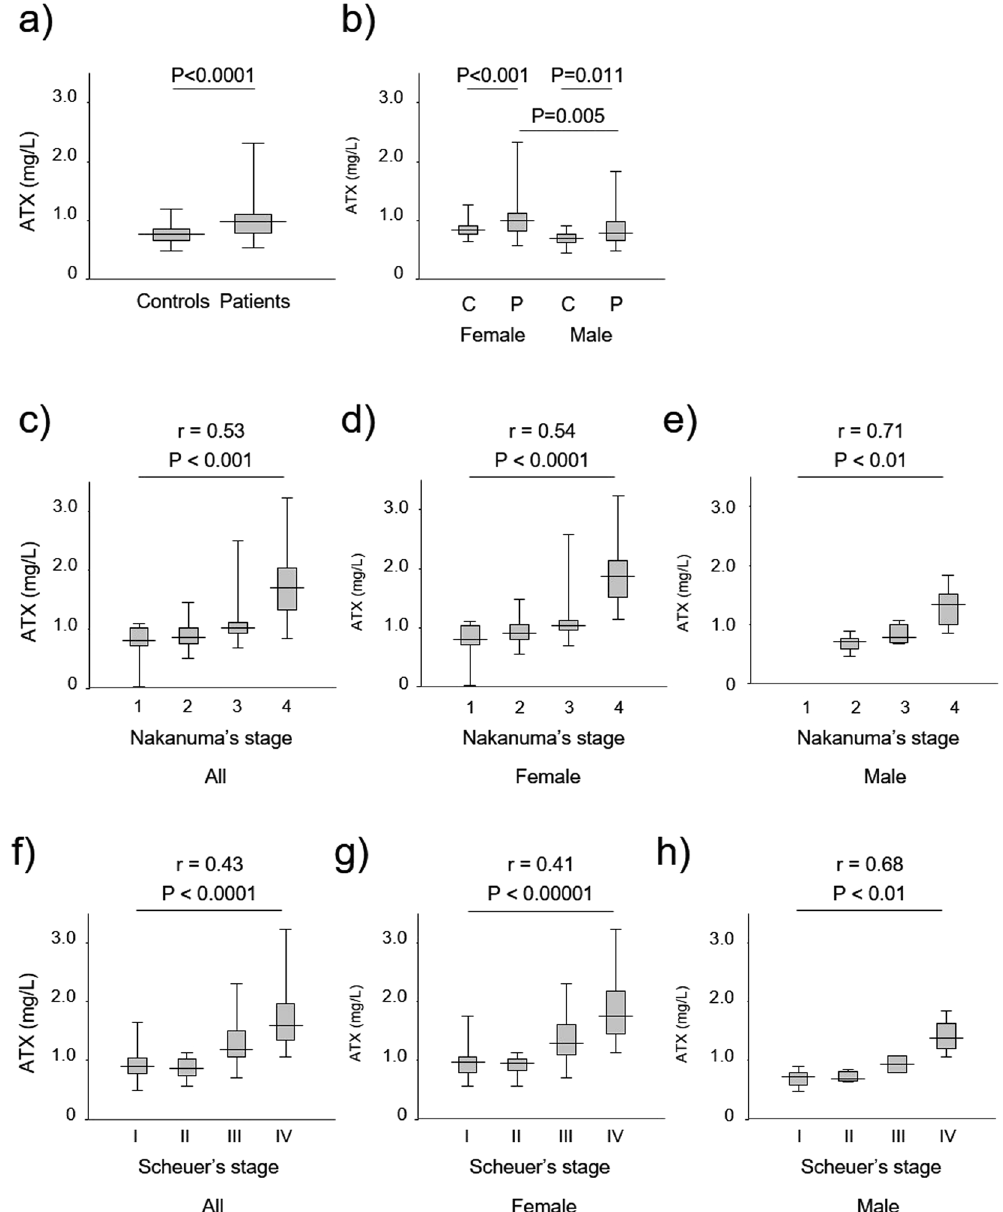
Figure 1. ( a ) Comparison of ATX levels between healthy controls and patients with primary biliary cholangitis. ( b ) Comparison of ATX levels in test groups according to gender. ( c – e ) Correlation of ATX and disease stage based on Nakanuma’s classification ( c ) in all patients, ( d ) in females only, and ( e ) in males only. ( f – h ) Correlation of ATX and disease stage based on Scheuer’s classification ( f ) in all patients, ( g ) in females only, and ( h ) in males only. The top and bottom of each box represent the first and third quartiles, respectively. The lines across the boxes indicate median values. Abbreviations: autotaxin, ATX; C, controls; P,